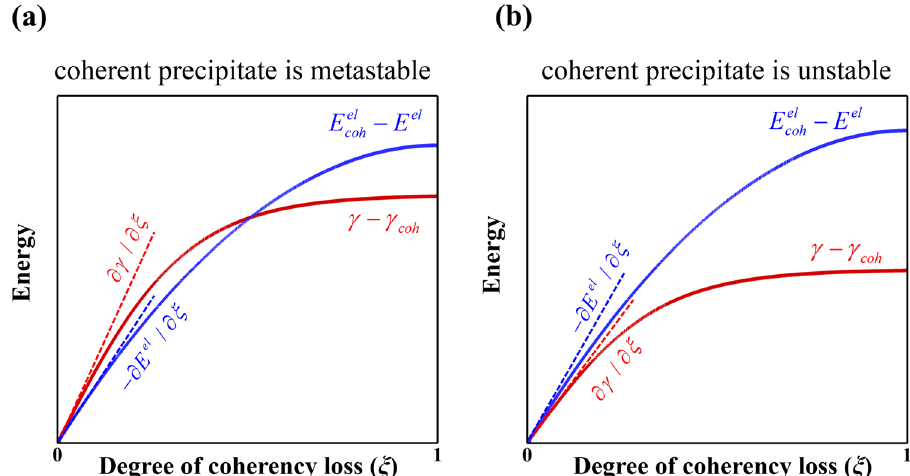
(cid:2) E el > γ (cid:2) γ coh but coh